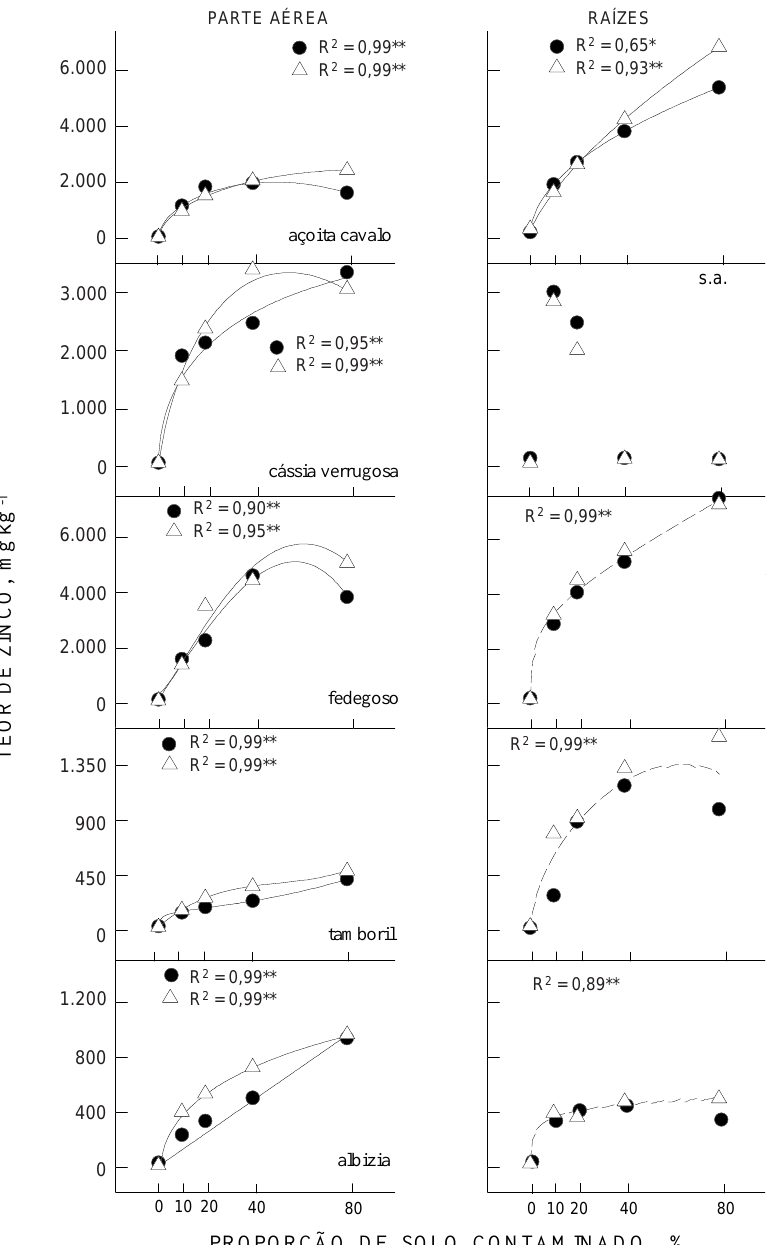
Figura 2. Teores de zinco no açoita-cavalo, cássia verrugosa, fedegoso, tamboril e albizia após o transplantio para mistura com diferentes proporções de solo contaminado: (cid:190) (cid:190)(cid:190) (cid:190)(cid:190) (cid:190)(cid:190) (cid:190)(cid:190) (cid:190) : plantas inoculadas; (cid:190)D(cid:190)(cid:190)D(cid:190)(cid:190)D(cid:190)(cid:190)D(cid:190)(cid:190)D(cid:190) ; plantas sem inoculação; -----: sem interação; s,a,: sem